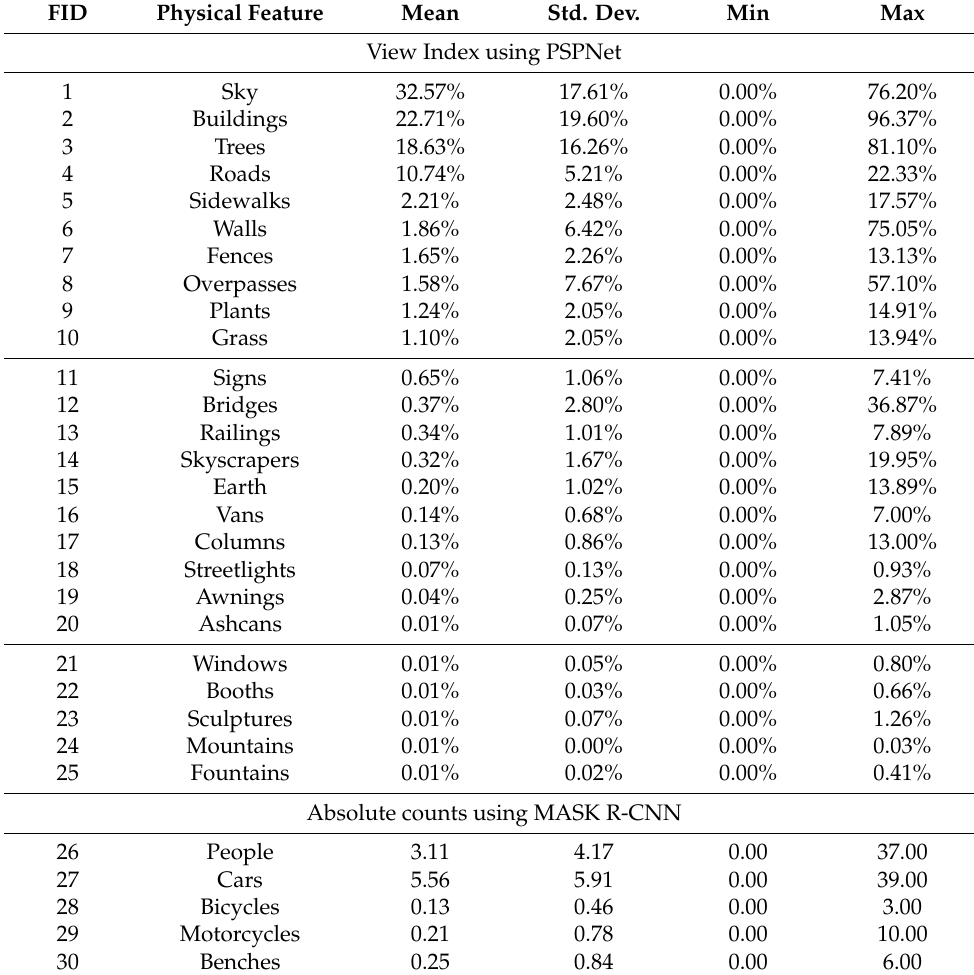
Table 1. Descriptive summary of 30 streetscape